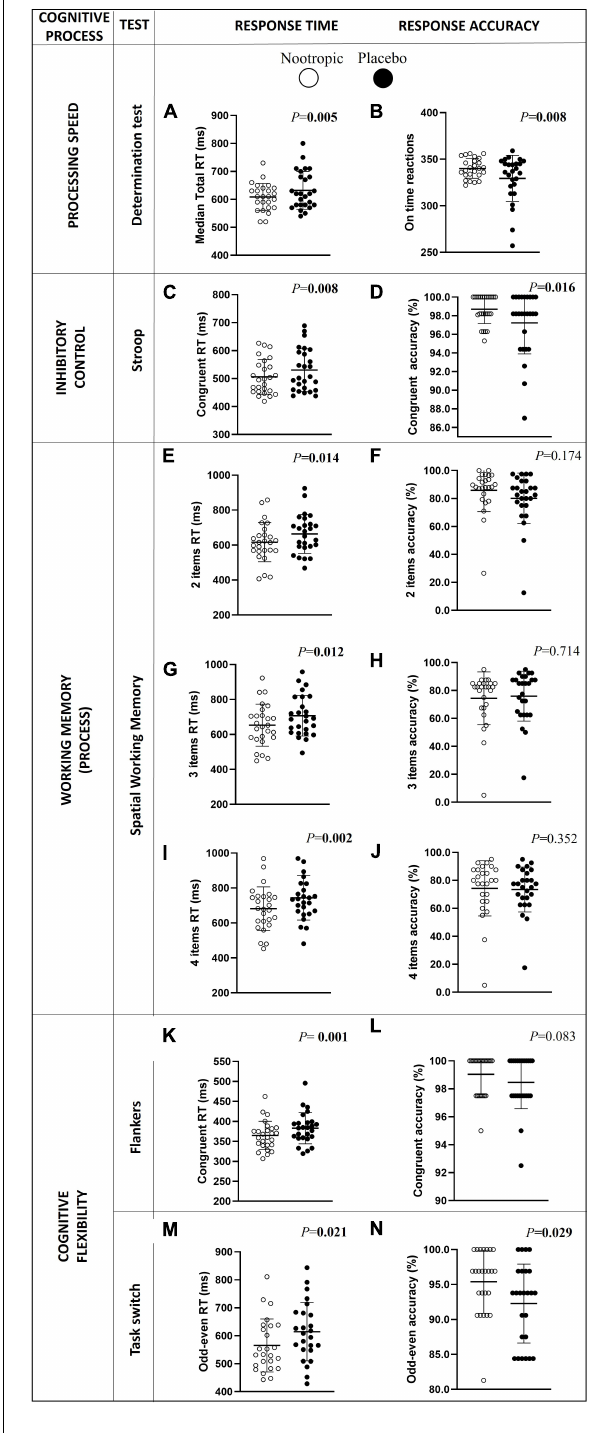
FIGURE 2 | Differences in choice processing speed (A,B) , inhibitory control (C,D) , spatial working memory (D–J) , and cognitive flexibility RT (K–N) and accuracy between the acute ingestion of the nootropic (denoted as white circles) and the placebo (denoted as black circles). Circles represent individual values, whereas lines represent mean (i.e., central line) and standard deviation. Differences between nootropic and placebo were analyzed using the Wilcoxon test. Boldfaced values mean P < 0.05. RT, response